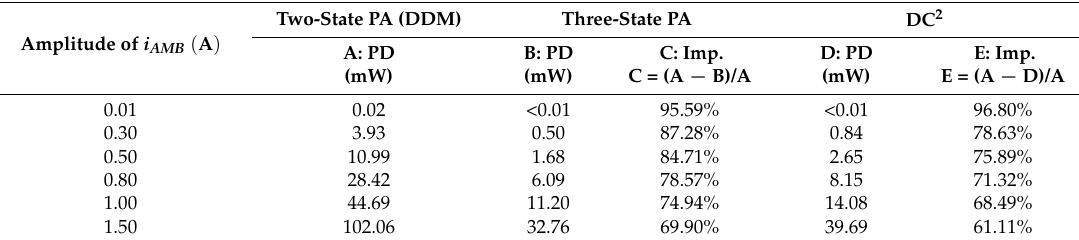
Table 4. Power dissipation at MOSFETs.